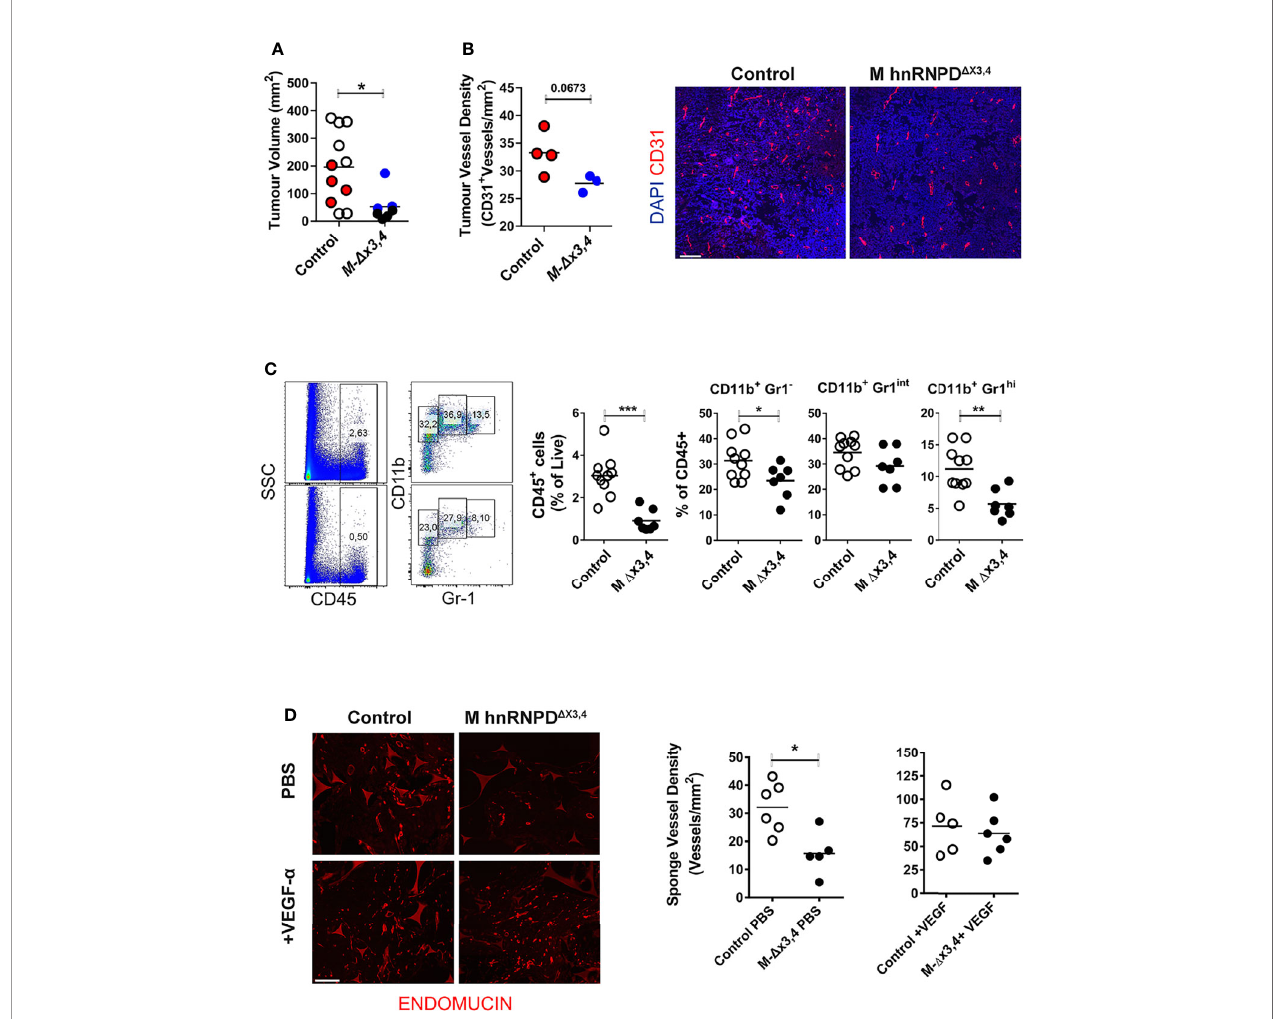
FIGURE 6 | The ablation of AUF1 functions in myeloid cells attenuates tumor in fi ltration and the vascularization of inert grafts. (A) Endpoint quantitation of subcutaneous B16F0 tumor sizes of control and M-hnRNPD D x3,4 mice. Scatter plots indicate individual values and means (lines) of tumor volumes, n=10 mice/per genotype. Colored circles indicate samples that were selected for the analysis in tumor vessels density. (B) Graphs (left) denote mean values ( ± SD) of blood vessels per mm2 of midline section of B16 tumor following immuno fl uorescent staining of midline with endothelial marker CD31 and counterstained via DAPI as indicated in the representative photomicrographs (right). (C) Quanti fi cation of the percentage of live total CD45+ cells and subgated myeloid cells detected via CD11b/Gr-1 expression in fi ltrating B16-tumors of control and M-hnRNPD D x3,4 mice as analyzed via fl ow cytometry analysis. Representative dot plots ( right ) and scatter plots ( left ) depicting individual values and means (lines) from n=11 mice/per genotype. (D) Endomucin staining patterns of midline sections of engraphed sponges (left) and quantitation of microvessel density in sponges from control and M-hnRNPD D x3,4 mice 14 days post administration of PBS or recombinant VEGF. Graphs denote mean values ( ± SD) of blood vessels per mm2 of midline sponge section of n=6 mice/genotype. In all graphs (*, **, ***) denote p values ≤ 0.05, ≤ 0.001 or ≤ 0.0001 respectively as determined via unpaired students t-test (on A ) or One-Way ANOVA (B – D)